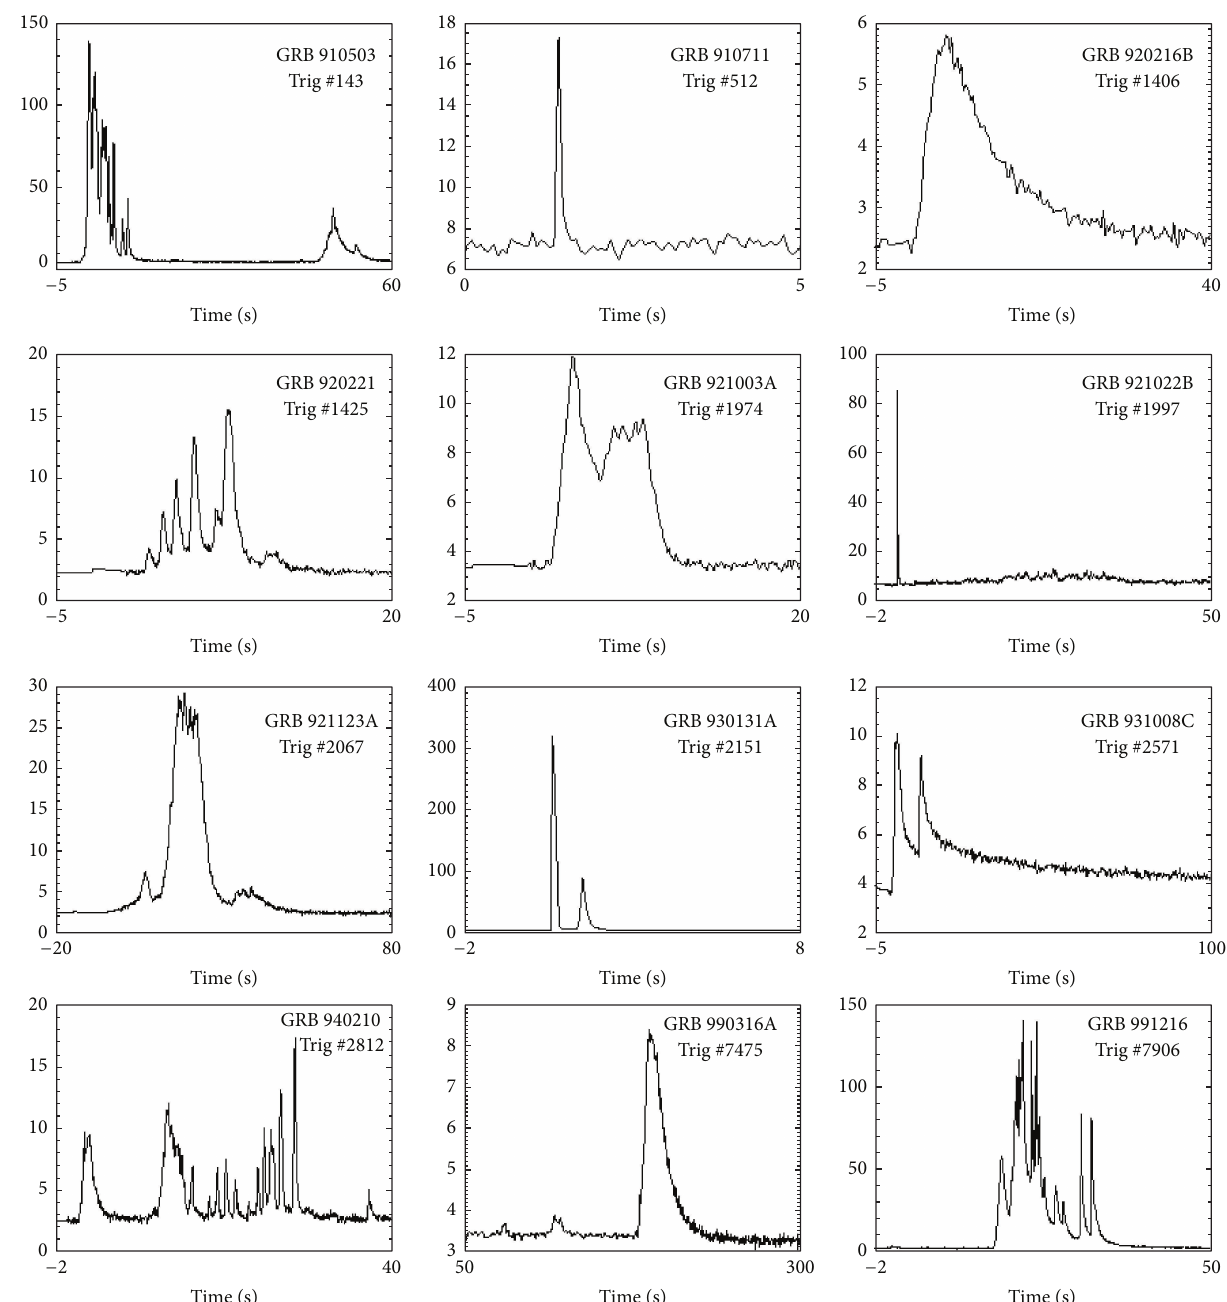
Figure 1: Light curves of 12 bright gamma-ray bursts detected by BATSE. Gamma-ray bursts light curves display a tremendous amount of diversity and few discernible patterns. This sample includes short events and long events (duration ranging from milliseconds to minutes), events with smooth behavior and single peaks, and events with highly variable, erratic behavior with many peaks. Created by Daniel Perley with data from the public BATSE archive